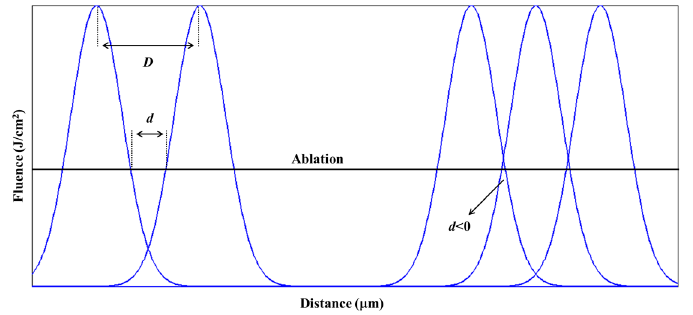
Figure 9. Schematic diagram of etching with multi laser beams with respect to distance.